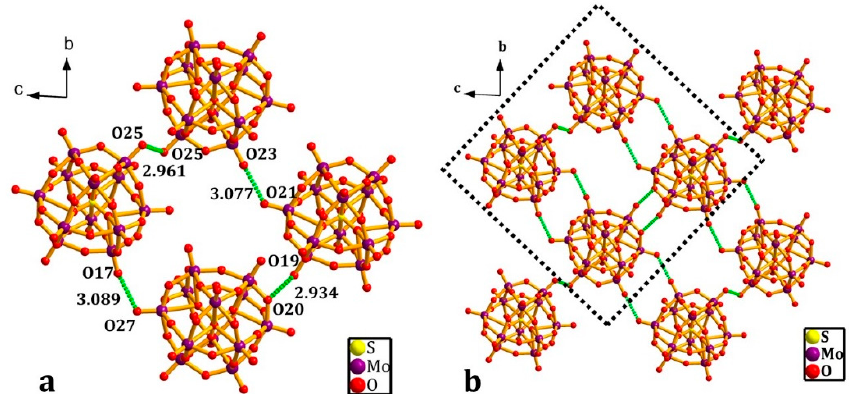
Figure 2. ( a ) The details of interaction between adjacent [SMo 12 O 40 ] polyoxoanions; ( b ) the packing of [SMo 12 O 40 ] polyoxoanions in the bc plane. ( a ) is the enlarged view of the dotted square fragment shown in ( b ); the dotted green line represents the O···O interaction.